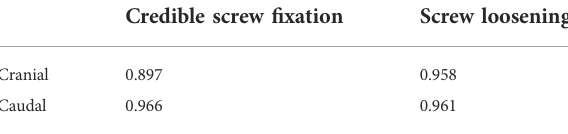
TABLE 3 Validationof consistency between HU valuesof the vertebral body and holding